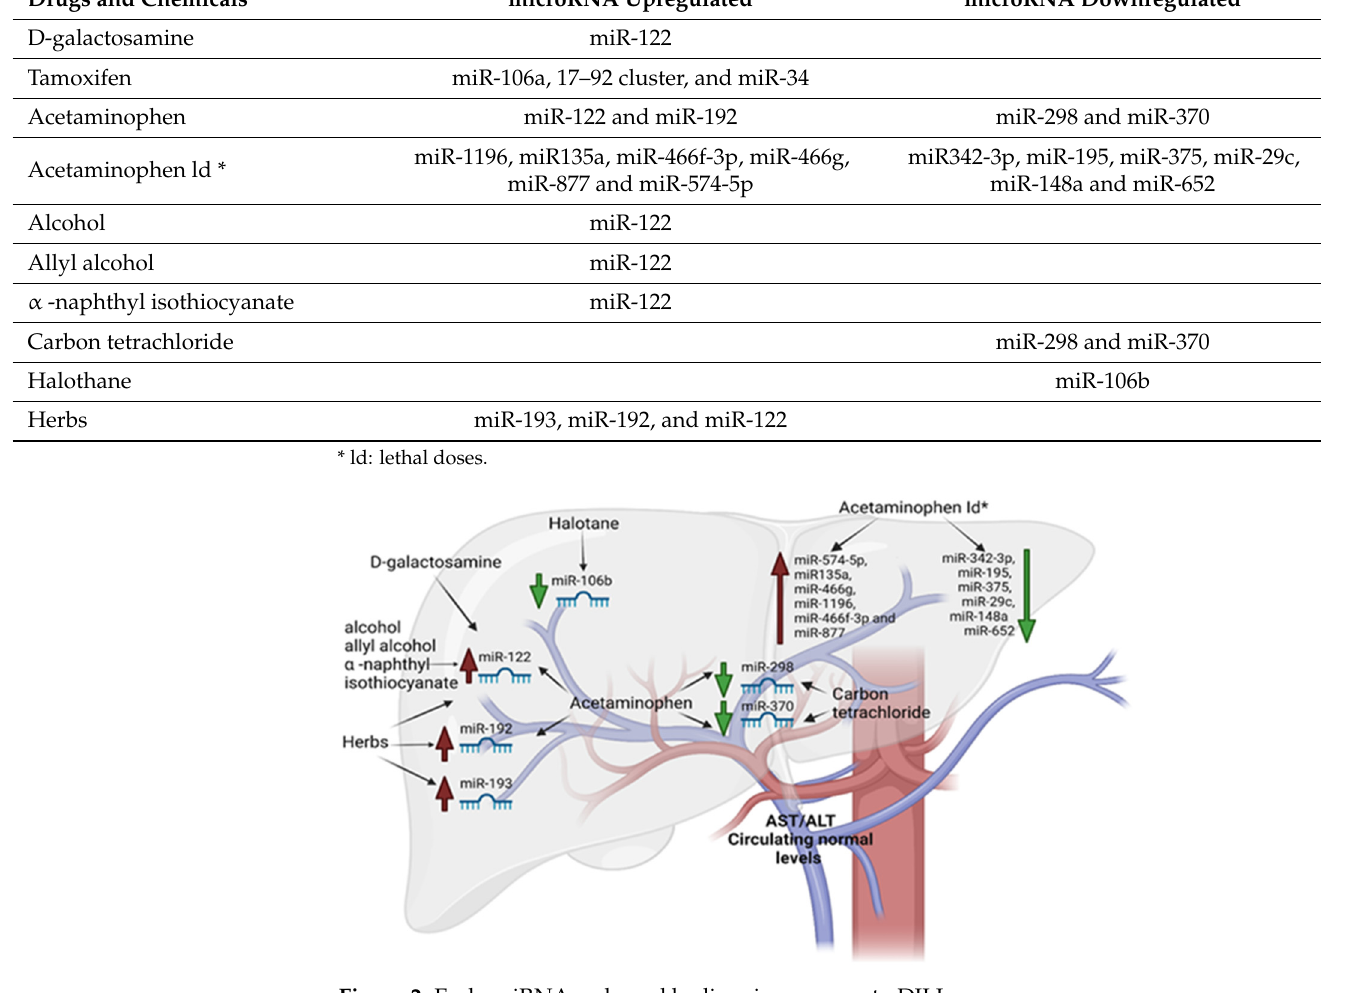
Figure 2. Early miRNAs released by liver in response to